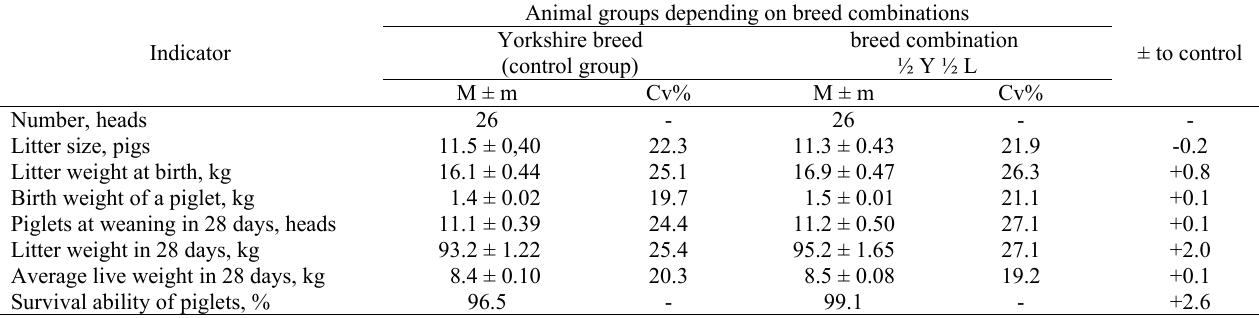
Results of fattening of crossbred boars Indicator Supplied for fattening animals, heads